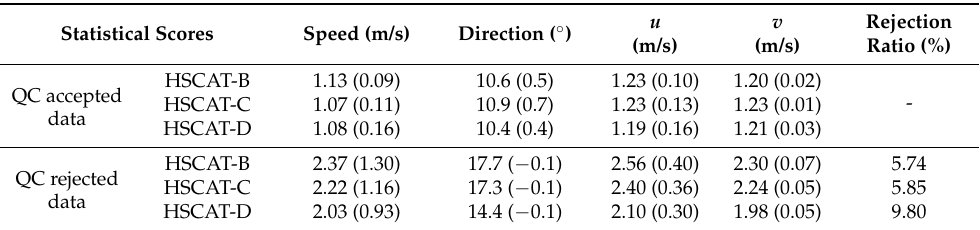
Table 2. Standard deviations of the difference between HSCATs and ECMWF winds. The biases of HSCATs’ wind components w.r.t. ECMWF are shown in the brackets.